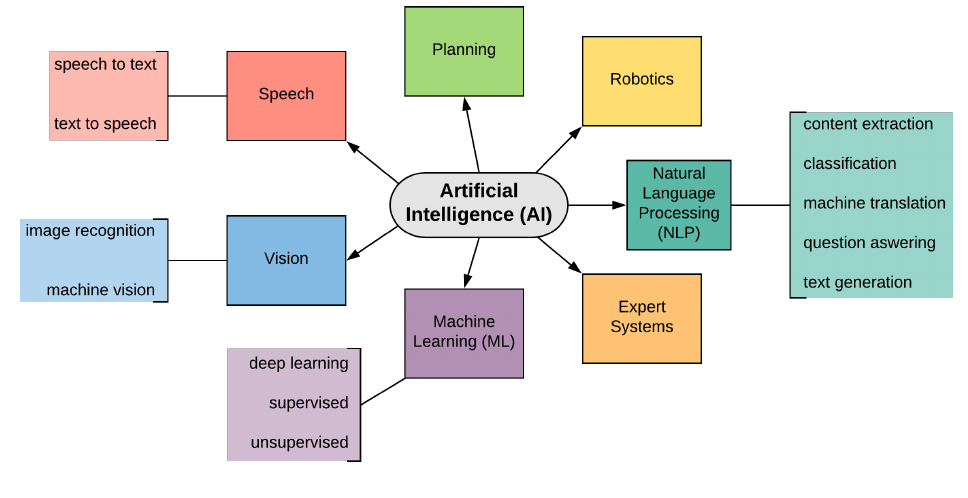
Figure 2. The branches of